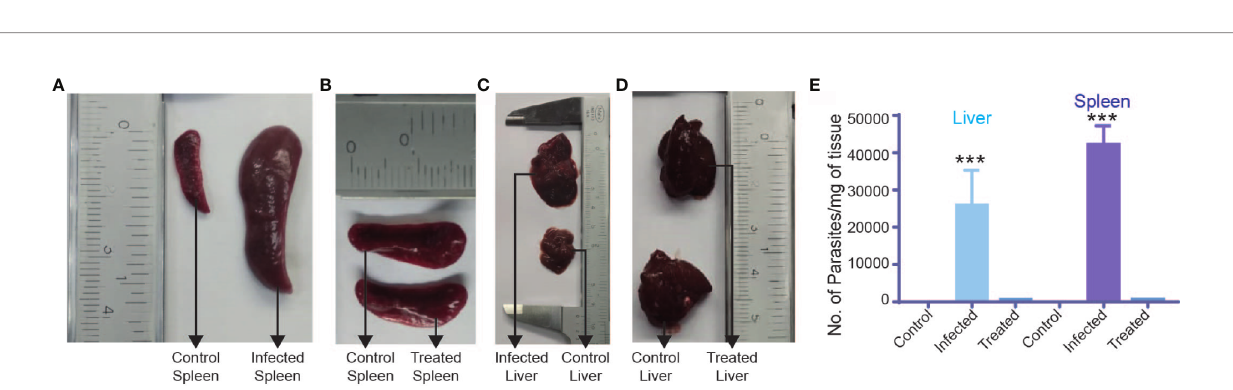
FIGURE 1 | Schematic of experimental plan. BALB/c mice were divided into three groups — control (red), infected (green) and treated (blue). The number of BALB/c mice used for sample collection in control, infected and treated groups is shown in the fi gure. Tissue and bio fl uid samples were collected from each group (the digits in the circle designate the number of mice) as shown. Samples were then prepared for GC derivatization followed by their processing in GC – MS (GCMS-QP2010 Ultra). Total Ion Chromatogram (TIC) was acquired here, and was further utilized for data processing and